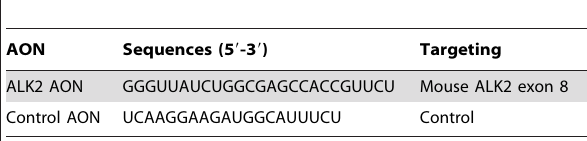
Table 1. Antisense oligonucleotides used in this study.